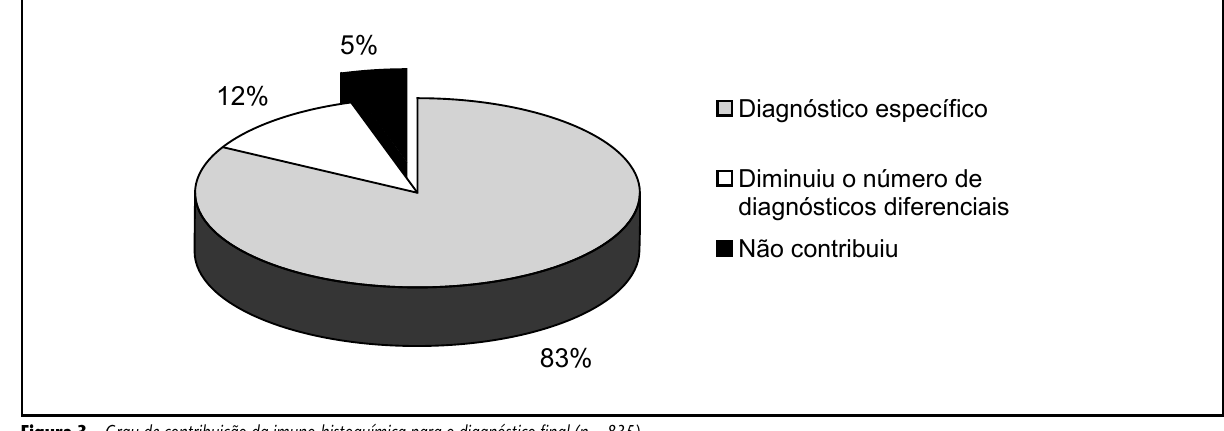
Figura 3 – Grau de contribuição da imuno-histoquímica para o diagnóstico final (n = 835)